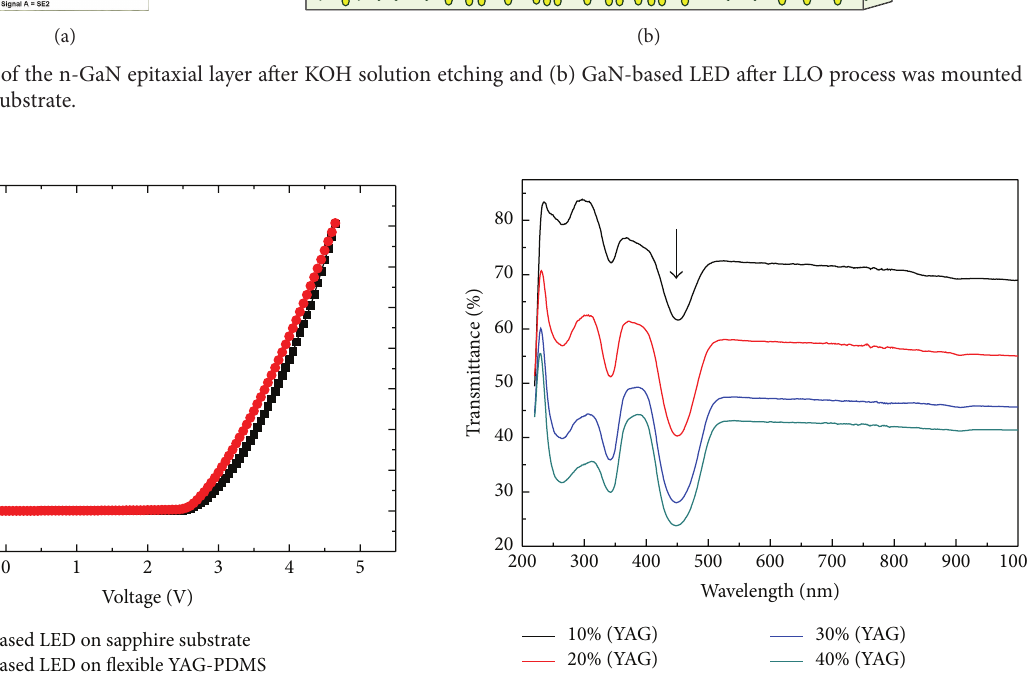
Figure 2: I-V curves of LEDs on sapphire substrate and YAG-PDMS substrate, respectively.